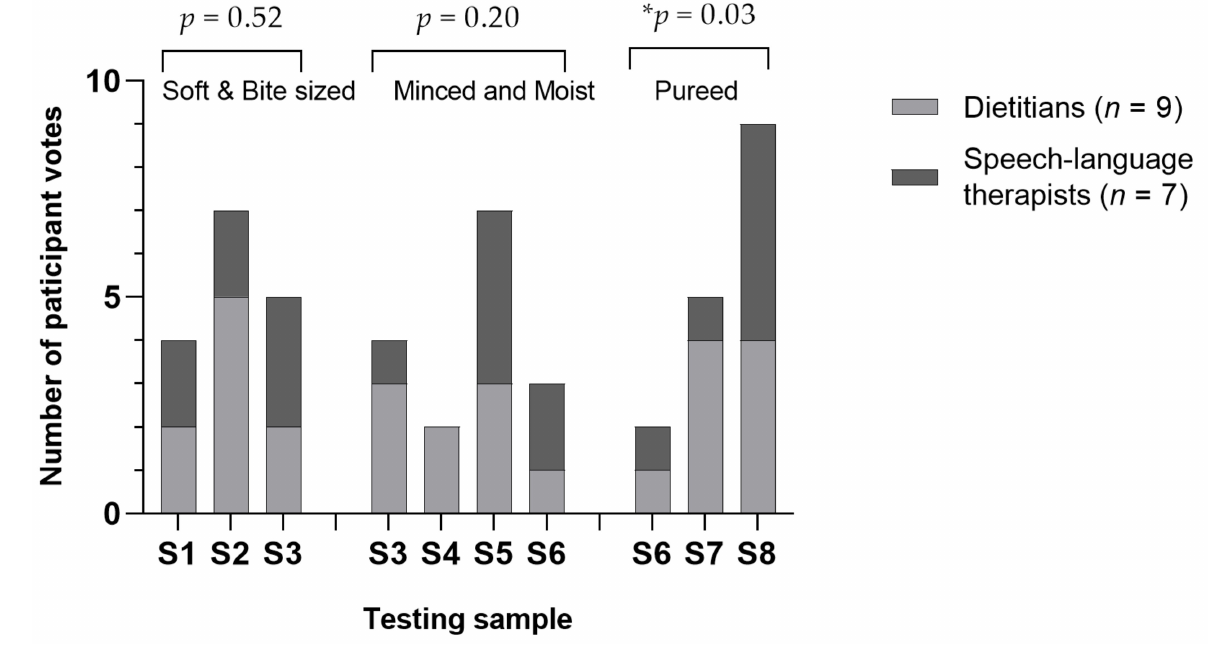
Figure 2. Healthcare professional votes for each level of texture-modified foods ( n = 16). S1 = freshly made Soft & Bite-Sized sample, S2 = sous-vide Soft & Bite-Sized sample, S3 = freshly made Minced & Moist sample, S4 = hydrolysed Minced & Moist sample, S5 = commercially packaged Minced & Moist sample, S6 = freshly made pureed sample, S7 = hydrolysed pureed sample and S8 = commercially packaged pureed sample. Chi-square test was performed to test the categorical variables. * p < 0.05 indicates significance.